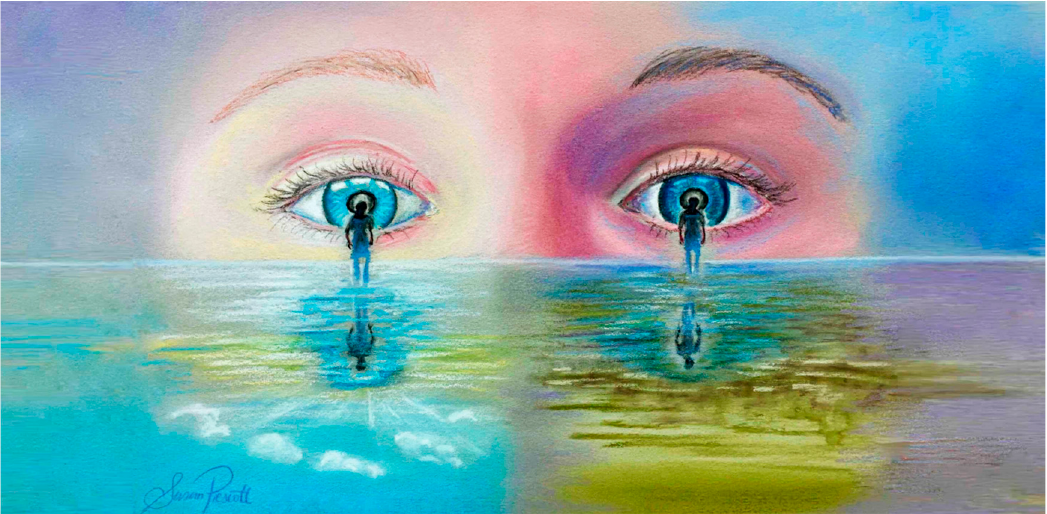
Figure 1. The stories we tell our children shape life-long attitudes to personal and planetary health, and the values that determine how they see themselves and the world around them. Our future depends on stories that promote a ‘planetary health psyche’ and translate into strong pro-health, pro-social, and pro-environmental attitudes and behaviors for future benefits at all scales.